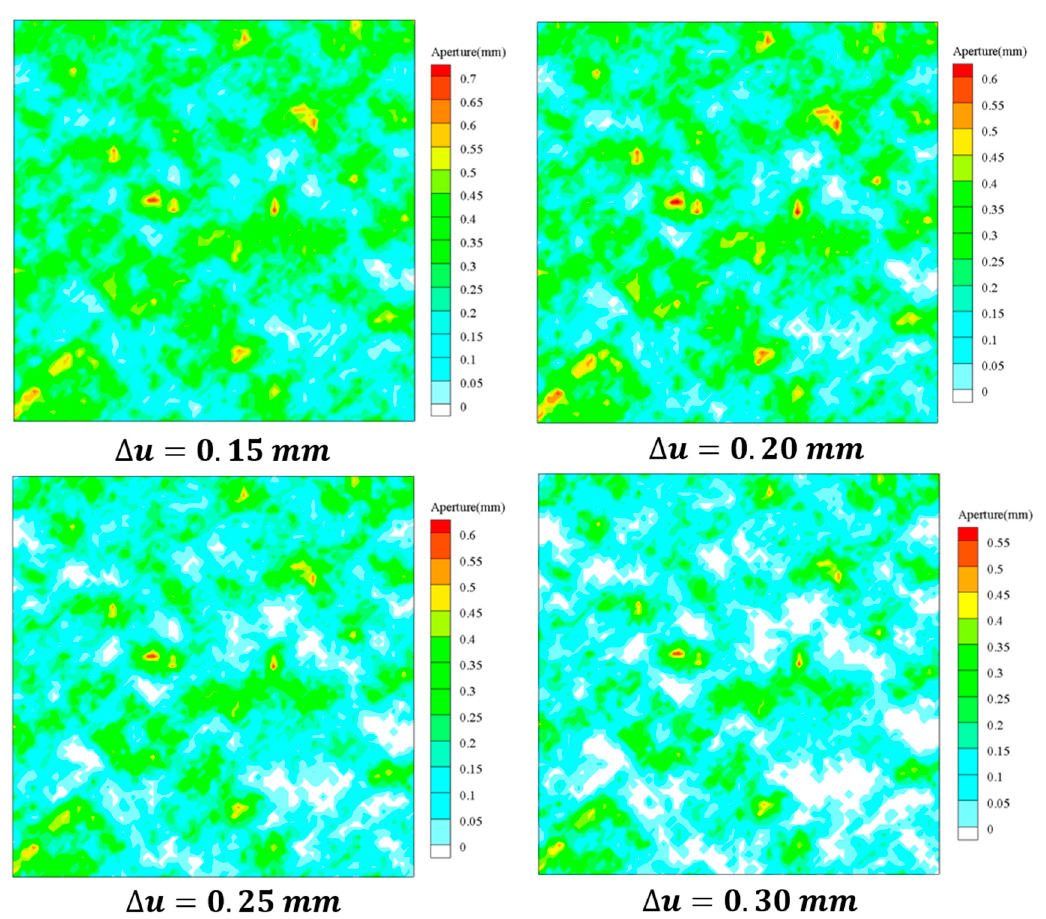
Figure 3. The evolution of aperture distribution for fractures of different normal deformation conditions with H = 0.50. The white regions are the contact areas, and the size of the apertures increases gradually from green to red.